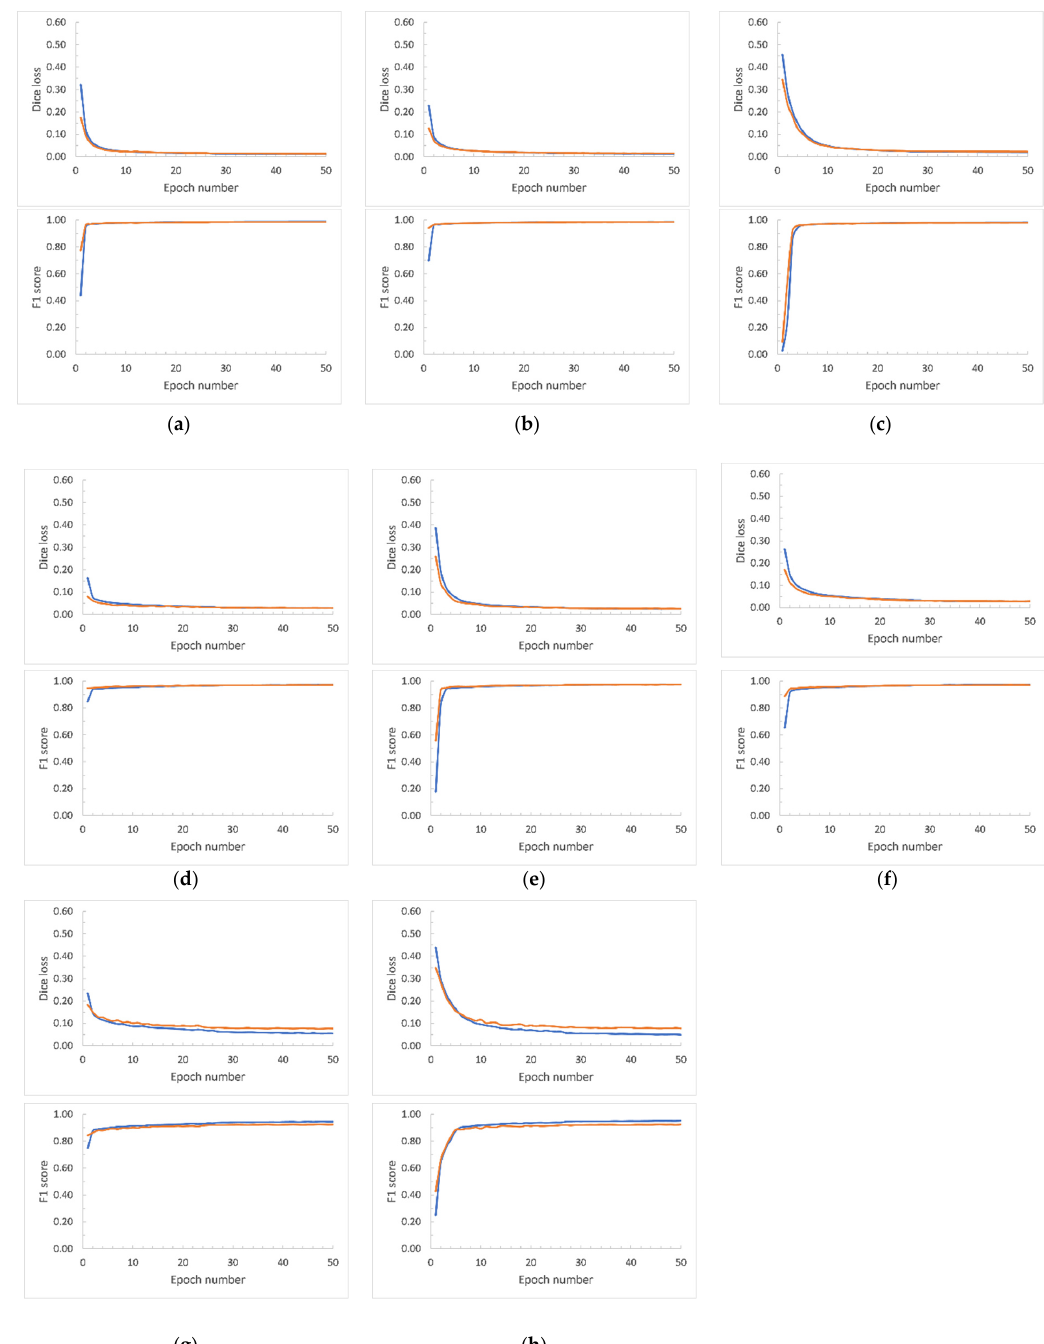
Figure 11. Training (blue line) and validation (orange line) Dice loss curves based on the hand- annotated data from the Eureka Sound Lowlands and Banks Island (combined RTS training data). Array sizes are shown in pixels. ( a ) Image tile size: 2048 × 2048. Network input size: 1024 × 1024. ( b ) Image tile size: 2048 × 2048. Network input size: 512 × 512. ( c ) Image tile size: 2048 × 2048. Network